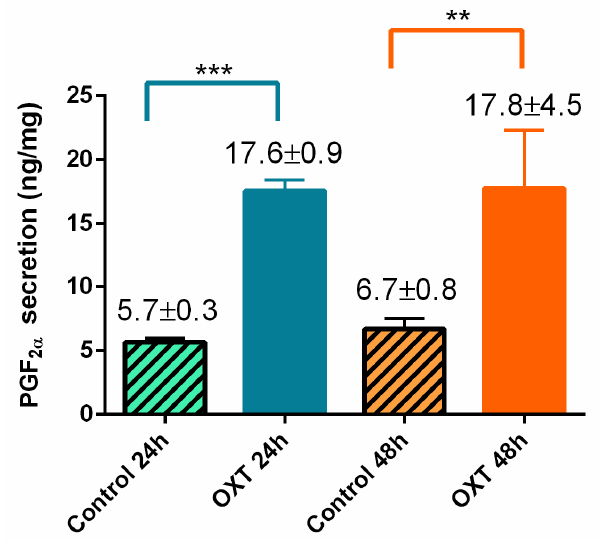
Figure 1. Equine endometrial explant secretion of prostaglandin (PG)F 2 α treated with oxytocin (OXT; 10 − 7 M) for 24 or 48 h. Secretion of PGF 2 α (ng/mL) is presented as mean ± SEM. Results were considered significant at p < 0.05. Asterisks represent statistical differences between OXT treatment and the respective control within the treatment time (** p < 0.01; *** p <